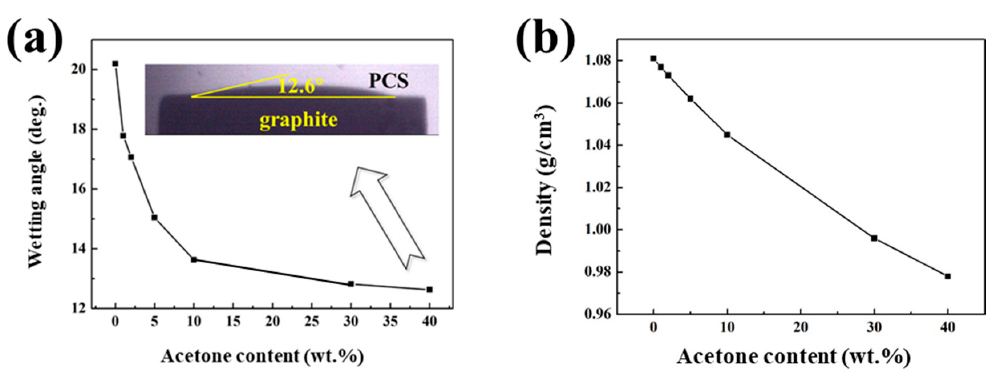
Figure 6. Curve of wetting angles between PCS/graphite and density of all mixtures with different acetone content, ( a ) wetting angles and ( b ) density.